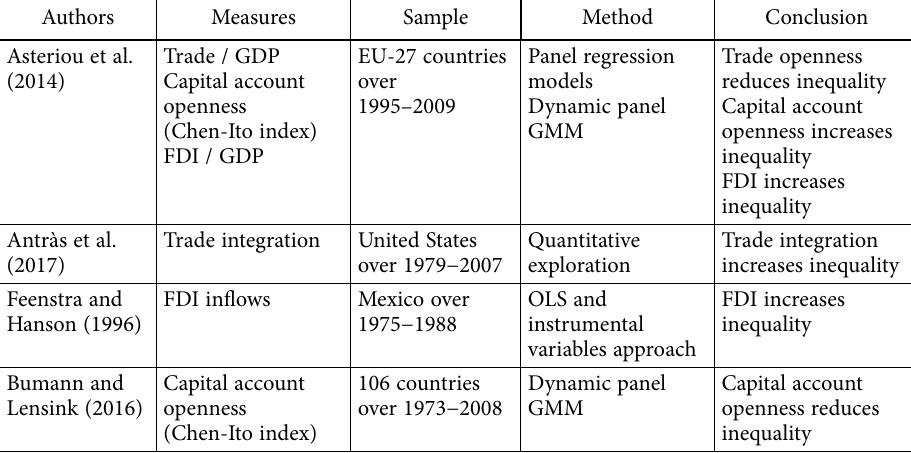
Table A1. Survey on globalization-inequality